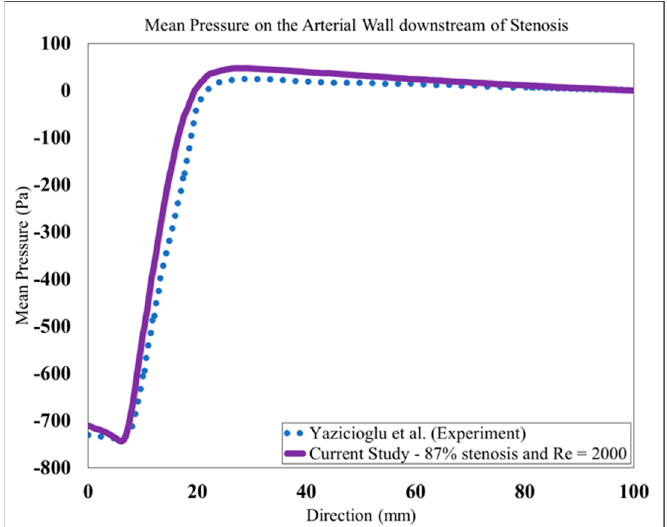
Figure 5. Mean pressure on the arterial wall in the post-stenotic region compared to [26]. The validation results showed that the LES turbulence model had a good agreement with experimental results, especially in the regions where the flow separation occurred, and the flow experienced the highest fluctuation about 1D to 4D downstream of the